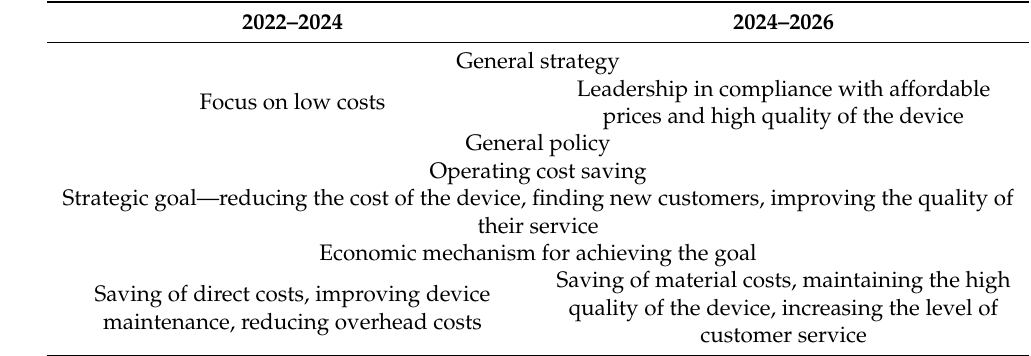
Table 9. Concept of providing competitive benefits for the period of project implementation for the commercialization of the interferometric determination of the refractive index of crystalline materials in the optical range 1